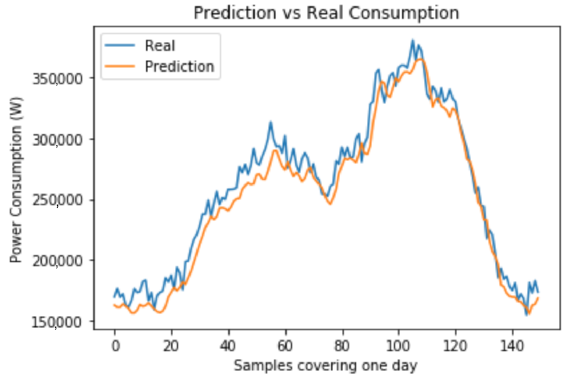
Figure 6. LSTM regression results over a day.